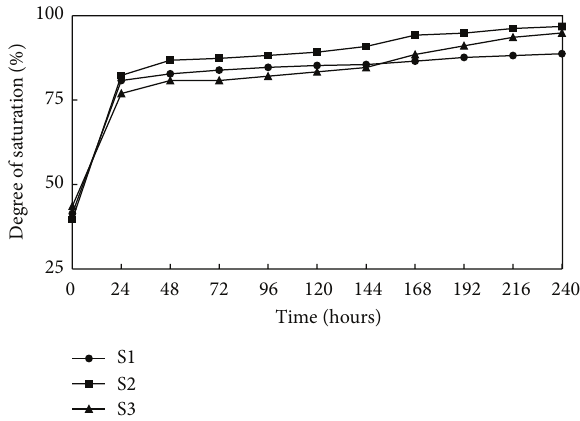
Figure 3: Curves showing relation between saturation degree of specimens and time submerged in